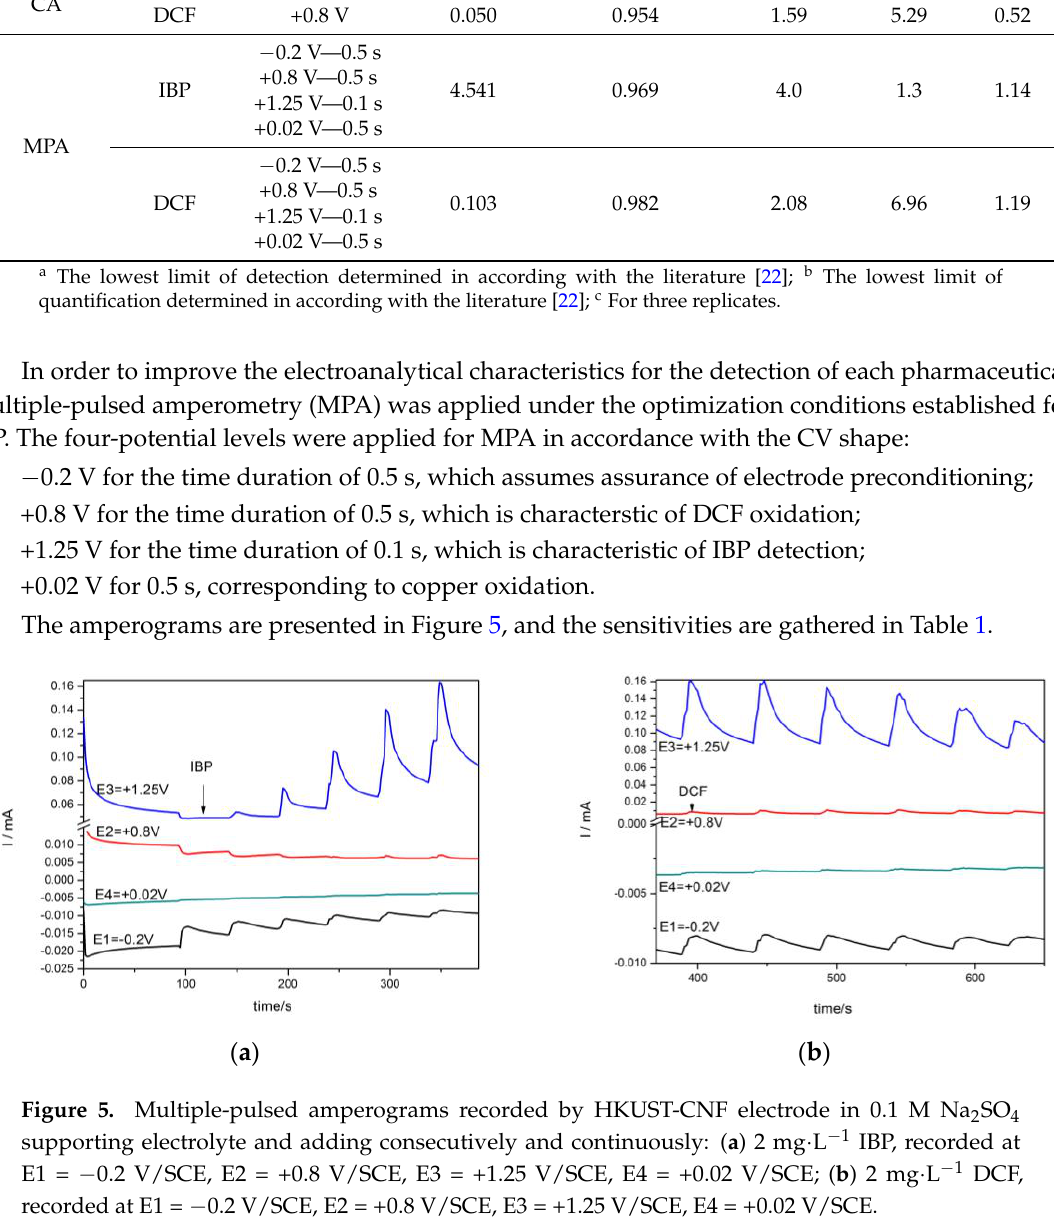
Figure 5. Multiple-pulsed amperograms recorded by HKUST-CNF electrode in 0.1 M Na 2 SO 4 supporting electrolyte and adding consecutively and continuously: ( a ) 2 mg·L −1 IBP, recorded at E1 = −0.2 V/SCE, E2 = +0.8 V/SCE, E3 = +1.25 V/SCE, E4 = +0.02 V/SCE; ( b ) 2 mg·L −1 DCF, recorded at E1 = −0.2 V/SCE, E2 = +0.8 V/SCE, E3 = +1.25 V/SCE, E4 = +0.02 V/SCE.